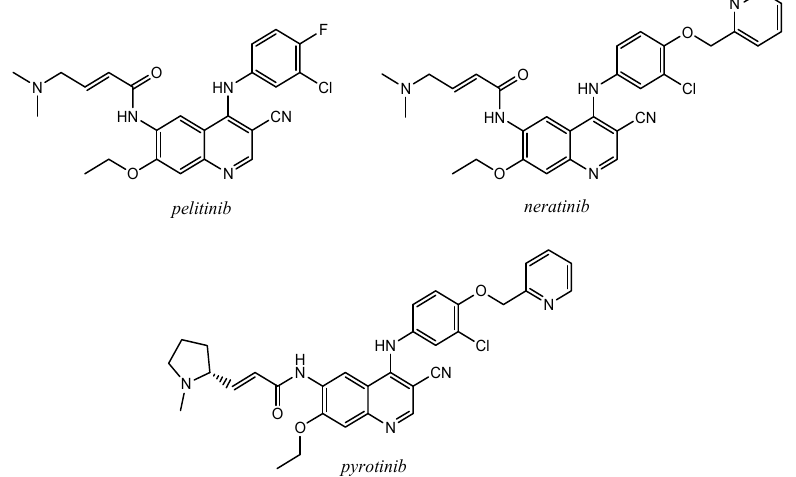
Figure 18. Structures of the irreversible EGFR inhibitors pelitinib (EKB-569), neratinib (HKI-272), and pyrotinib (SHR-1258).